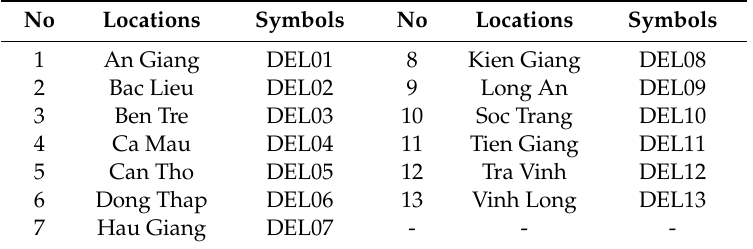
Table 3. List of the 13 locations identified in Mekong Delta, Viet Nam.